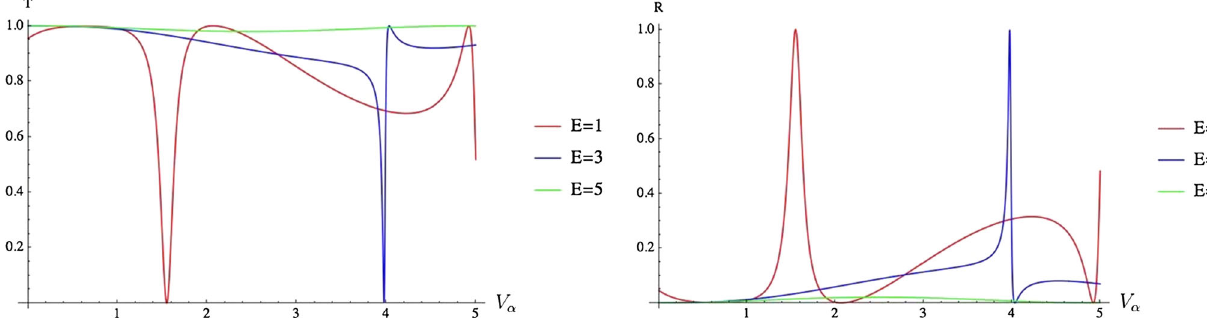
Fig. 6 Treatments of reflection and transmission coefficients for a fixed value of the imaginary part of the potential and different